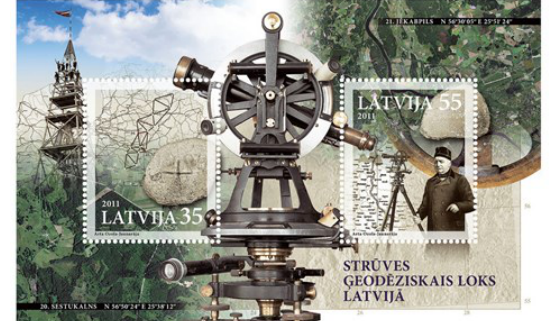
Figure 1. The Struve Geodetic Arc on stamps of Latvia. Winner of the Latvian stamp competition 2011.